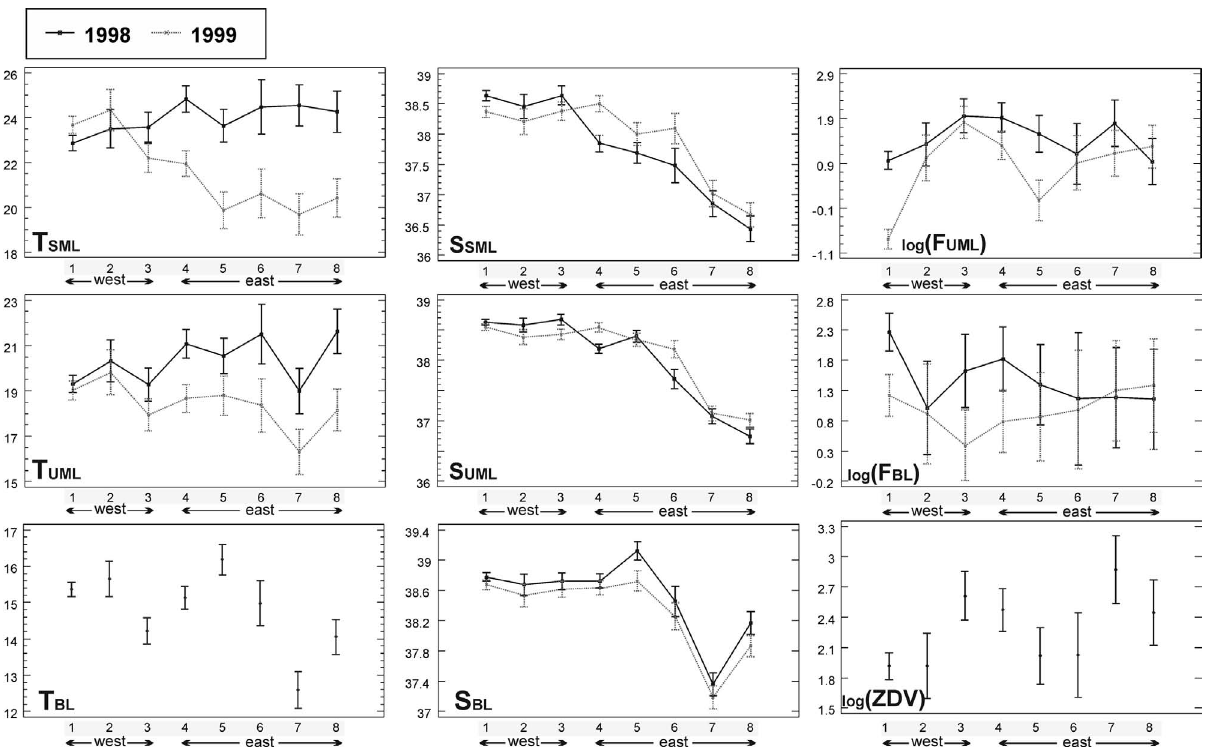
Fig . 3. – Mean values and 95% Bonferroni-corrected confidence intervals for temperature (T), salinity (S), integrated fluorescence (F) and zooplankton displacement volume (ZDV) for the different depth layers (UML, upper mixed layer; SML, surface mixed layer; BL, bottom layer) and sub-regions (1, Ionian Sea; 2, Patraikos Gulf; 3, Korinthiakos Gulf; 4, Saronikos Gulf; 5, Aegean Sea; 6, S. Evoikos Gulf; 7, N. Evoikos Gulf; 8, Pagasitikos Gulf). The effect of year and the year*sub-region interaction was not significant (P>0.05) for temperature in the BL and